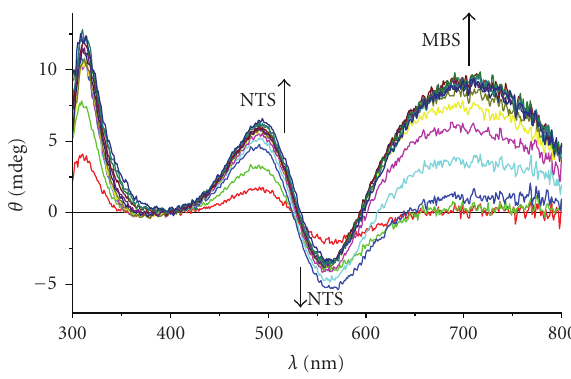
Figure 1: CD spectra of Cu(II) titration of HSA (0.5mM in 0.1MNaCl, pH 7.4), from 0 to 3 mol equivalents, at a 0.25 mol equivalent